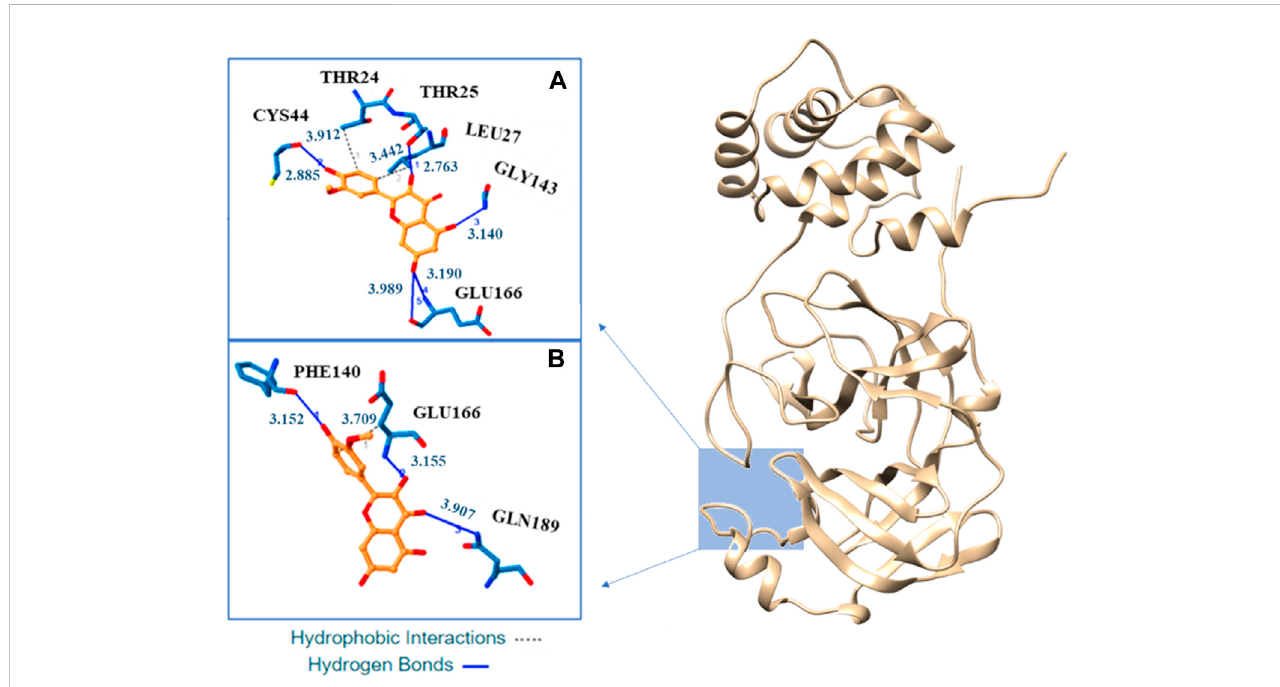
FIGURE 5 Three-dimensional representation of the best docking pose for H 4 Iso (A) and H 3 Is − (B) species. The residues that have crucial contacts with the compounds are shown in the square windows (A,B) , for H 4 Iso and H 3 Is